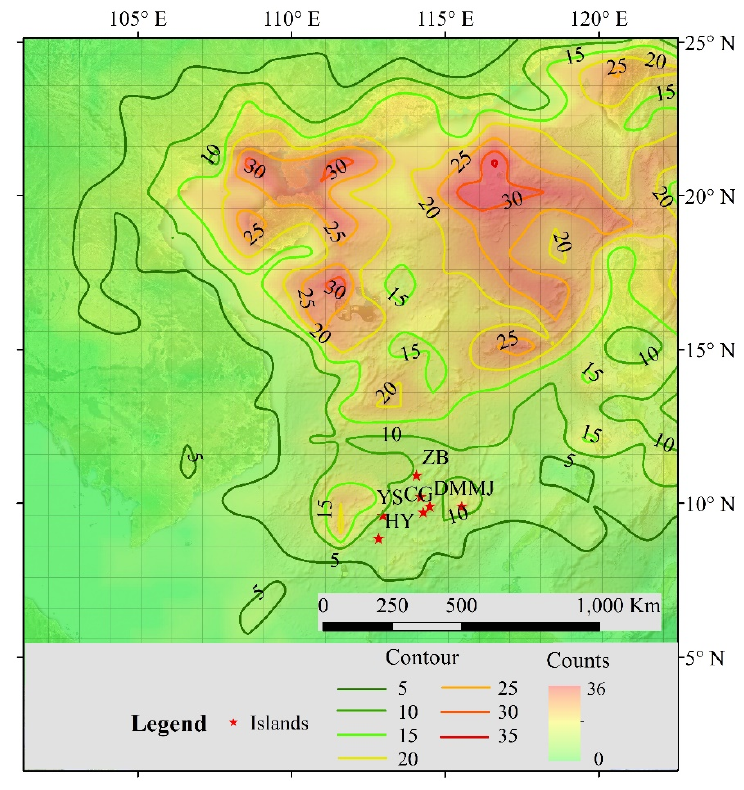
Figure 2. Spatial distribution of TCs over 18 years (2001–2018).